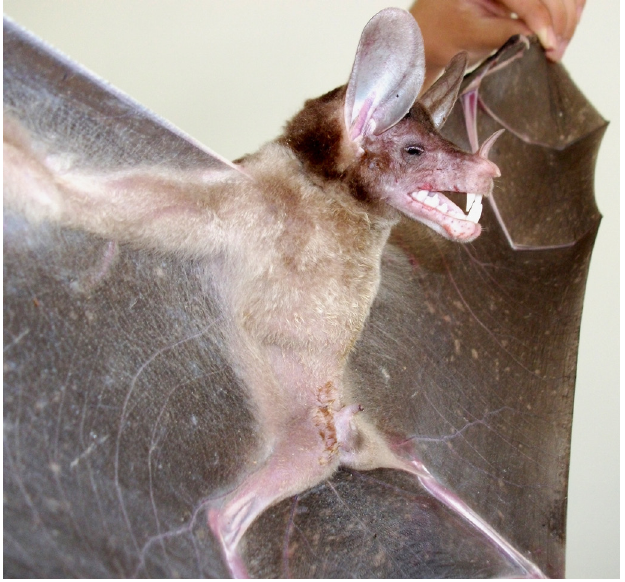
Figure 2. Vampyrum spectrum individual (RM 123), captured in Nova Xavantina, state of Mato Grosso, Brazil (Photo by Sousa,